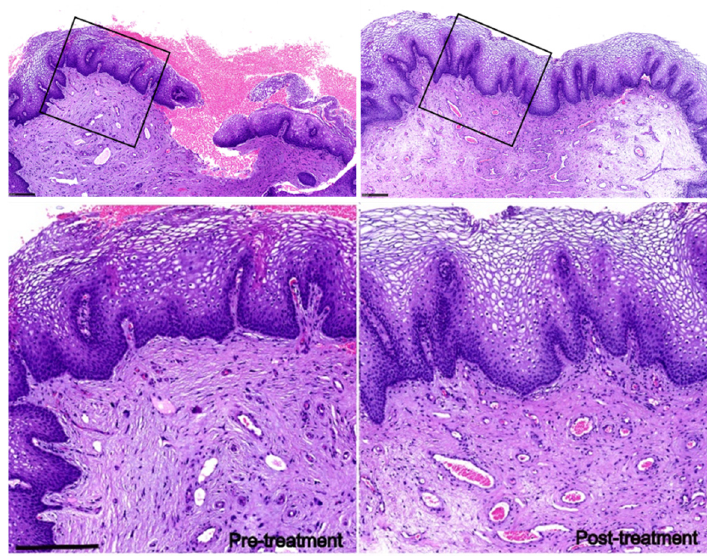
Figure 2. Laser treatment improves vaginal tissue physiological properties in patients with VL. H&E staining of vaginal biopsies taken from subject 1 (50 years old) before and one month after treatment. Scale bar: 250 µm.